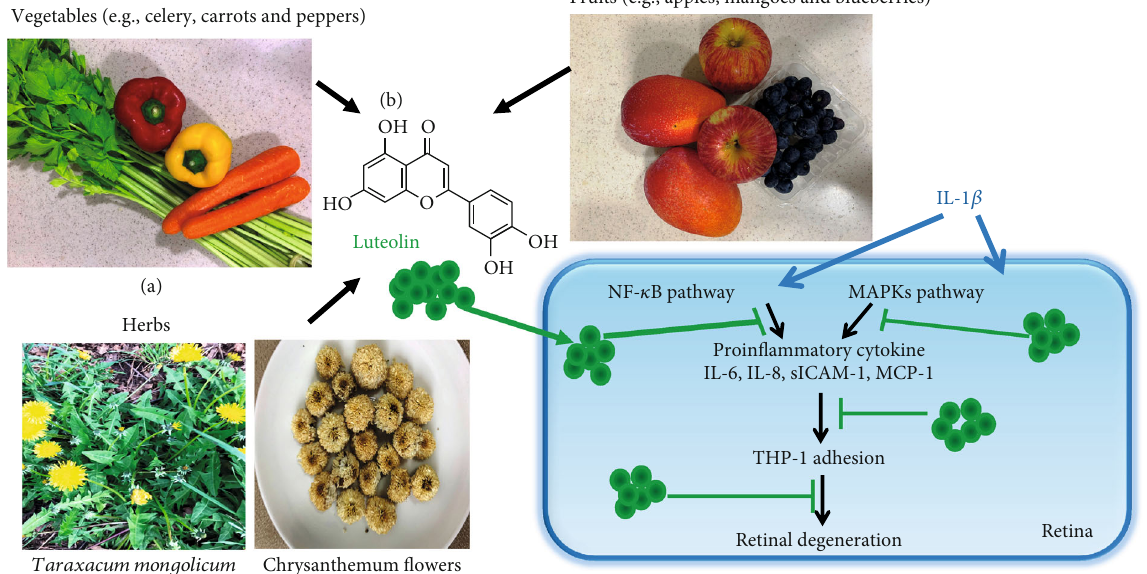
Figure 1: Experimental abstract. (a) Foods containing luteolin. (b) The structure of luteolin. (c) Pathways likely related to the anti- in fl ammatory activity of luteolin in IL-1 β -stimulated ARPE-19